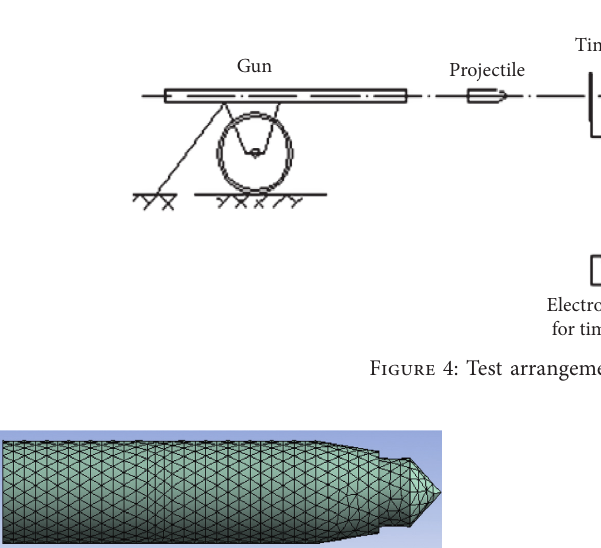
Figure 5: FEM model of projectile. Table 1: Material parameters of the projectile body model. ρ (kg/